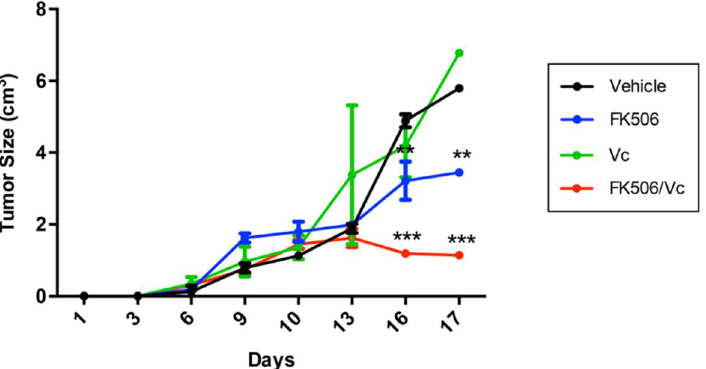
Figure 4. Vincristine in co-treatment with FK506 decreases tumor growth in vivo. A subcutaneous tumor was generated in Sprague-Dawley rats with C6-derived GSCs. Ten days post-inoculation, rats were treated with vehicle (black), FK506 (blue; 2.25 mg/kg/72 h/intravenous), Vc (green; 0.3 mg/kg/72 h/intravenous) or FK506/Vc (red) for seven days. The graph represents tumor volume (in cm 3 ) over a total of 17 days. Graphs represent the mean ± S.D. ** p < 0.01 and *** p < 0.001 versus vehicle. n = 4.